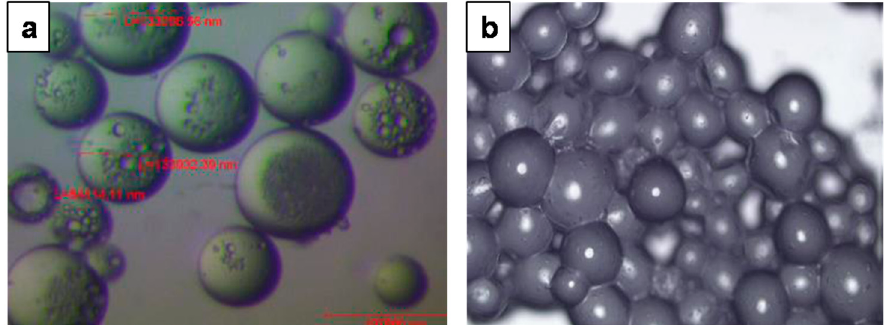
Figure 4. Morphology of capsules under a light microscope with a 10× magnification objective. ( a ): Simple coacervation freshly after capsules’ harvesting. ( b ): Complex coacervation freshly after capsules’ harvesting. Reprinted from IOP Conf. Ser. Mater. Sci. Eng ., 2018, 358, 012072. Copyright 2018 IOP Science.